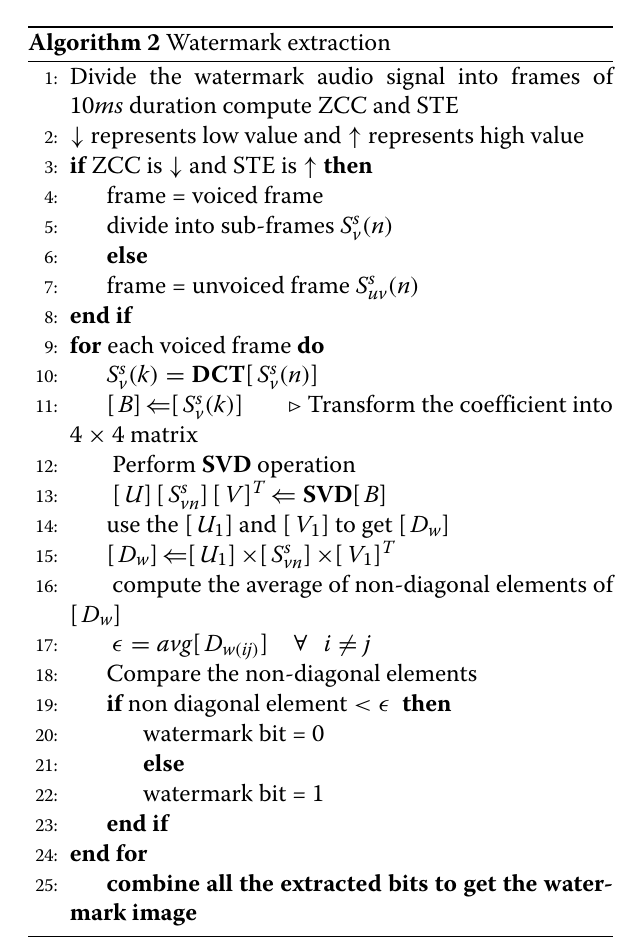
Algorithm 2 Watermark